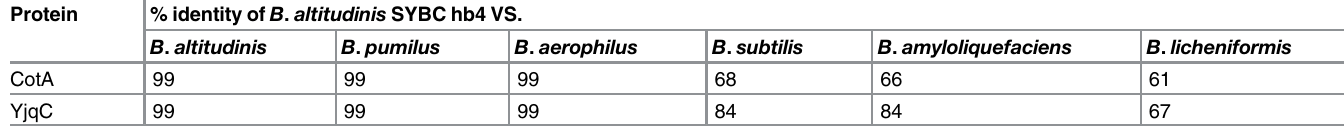
amino acid sequence showed high sequence homology (99%) to CotA of B . altitudinis , B . pumi- lus and B . aerophilus (Table 2). In contrast, the homologous CotA from B . licheniformis , B . amyloliquefaciens and B . subtilis exhibited 61, 66 and 68% sequence identity with B . altitudinis hb4 CotA, respectively. The phylogenetic tree also suggested that B . altitudinis hb4 CotA shared a close relationship with CotA of B . altitudinis and B . pumilus (Fig A in S1 File). Table 2. Sequence conservation (shown as % identity) of CotA and YjqC among Bacillus species. Protein % identity of B . altitudinis SYBC hb4